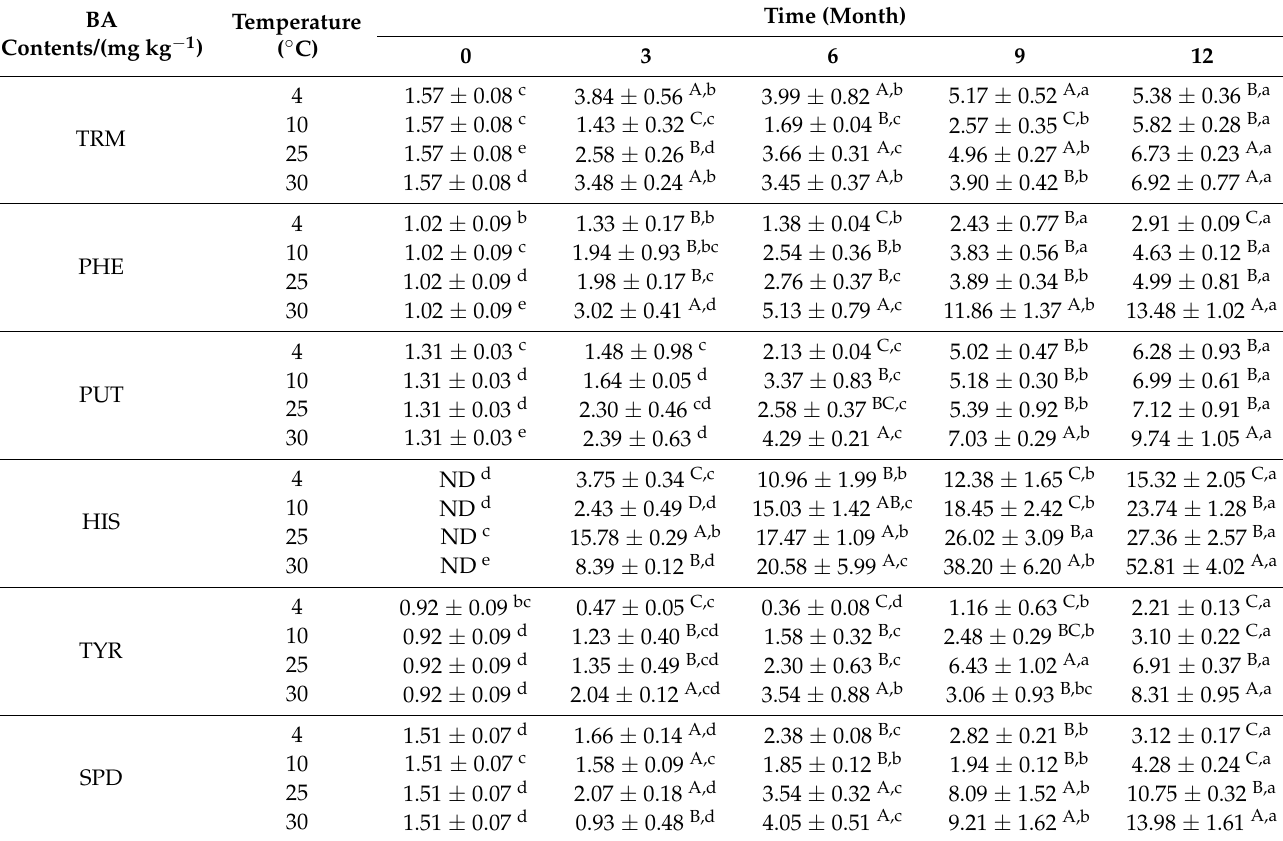
Table 1. Changes of BAs in canned mud carp during storage at different